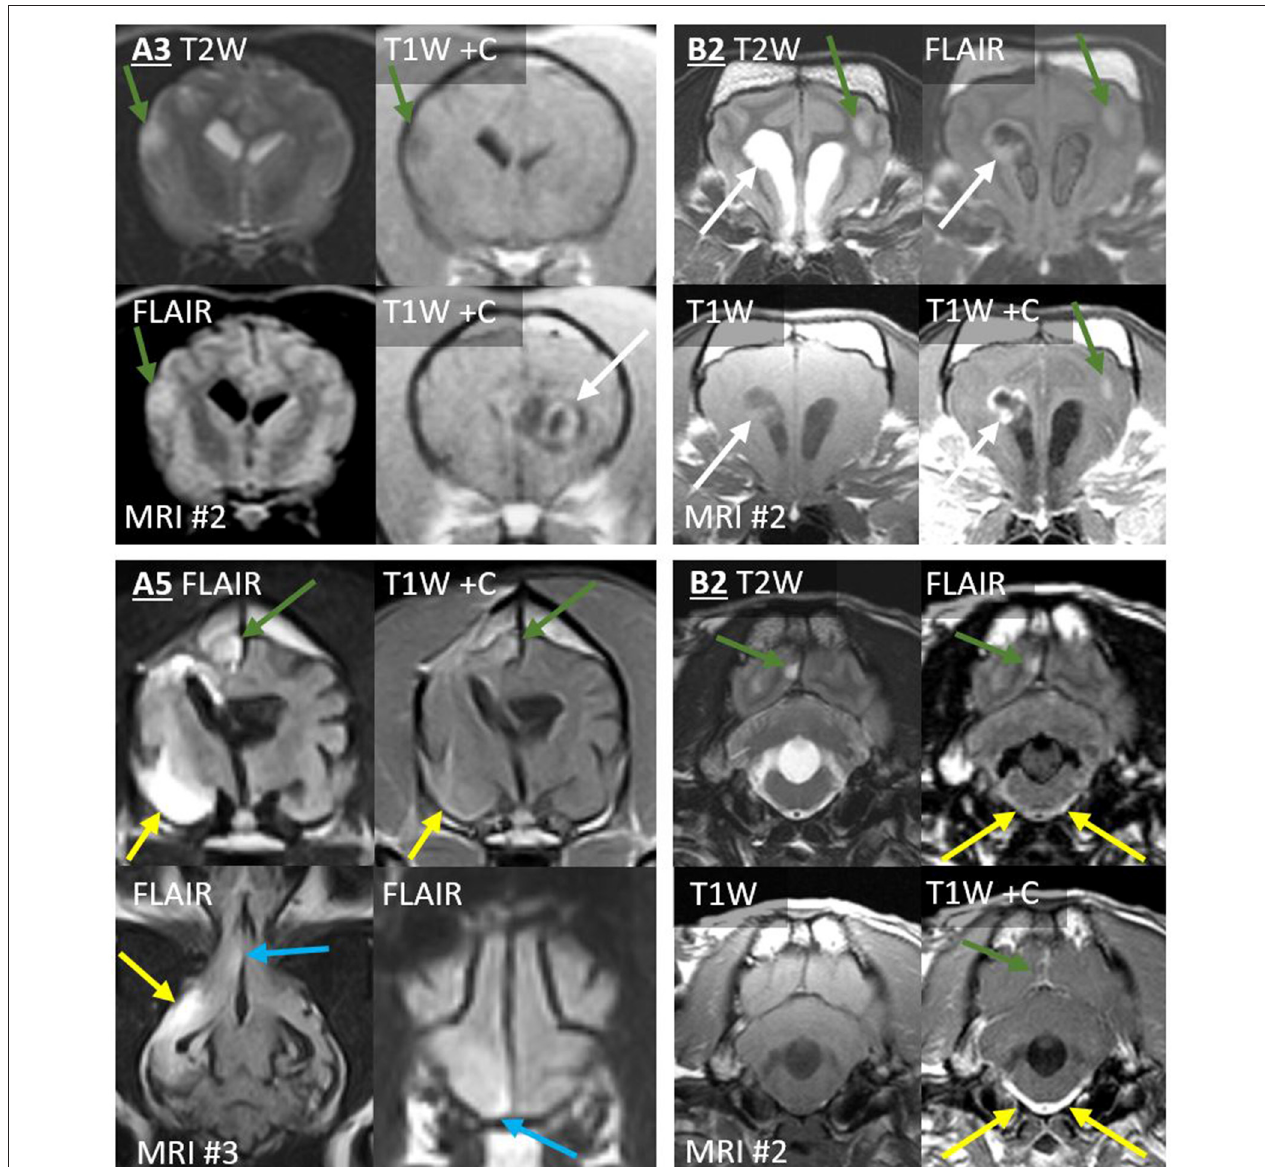
FIGURE 4 | Type 1a CSF drop metastases: Leptomeningeal nodular lesions. Images of Case A3 ( top left ) are transverse (level of the internal capsule, except one image at the level of the primary mass). Images of Case A5 ( bottom left ) are 6 months post-operative (top, transverse images of the third ventricle; bottom, dorsal image of the ventral falx cerebri and transverse image of the rostral frontal lobe). Images of Case B2 are transverse at the level of the frontal lobes ( top right ) or at the level of the fourth ventricle ( bottom right ). Primary masses displayed heterogeneous signals and irregular contrast enhancement (white arrows). Leptomeningeal metastatic nodules (green arrows) did not resemble the primary mass, having homogenous signals, and being non-enhancing (A3), homogenously-enhancing (A5 and upper B2), or displaying only leptomeningeal enhancement (lower B2). In Case A5, largest metastasis (yellow arrows) displayed extensive parenchymal FLAIR-hyperintensity with leptomeningeal enhancement. Additionally, ependymal FLAIR-hyperintensity and contrast enhancement extend from the resection cavity. A leptomeningeal metastatic nodule (blue arrows) in the ventral frontal lobe abuts the falcine CSF. These lesions had not been present on the pre- or post-operative MRIs. In Case B2, the three leptomeningeal nodules (green arrows) had not been present on MRI #1. T2-hyperintense and T1-hypointense signals extend ventrally from the rostral horns. There is concurrent, very thick, and strong leptomeningeal enhancement ventral to the medulla and surrounding the basilar artery; this lesion is FLAIR-hyperintense (yellow arrows). Fourth ventricle is severely